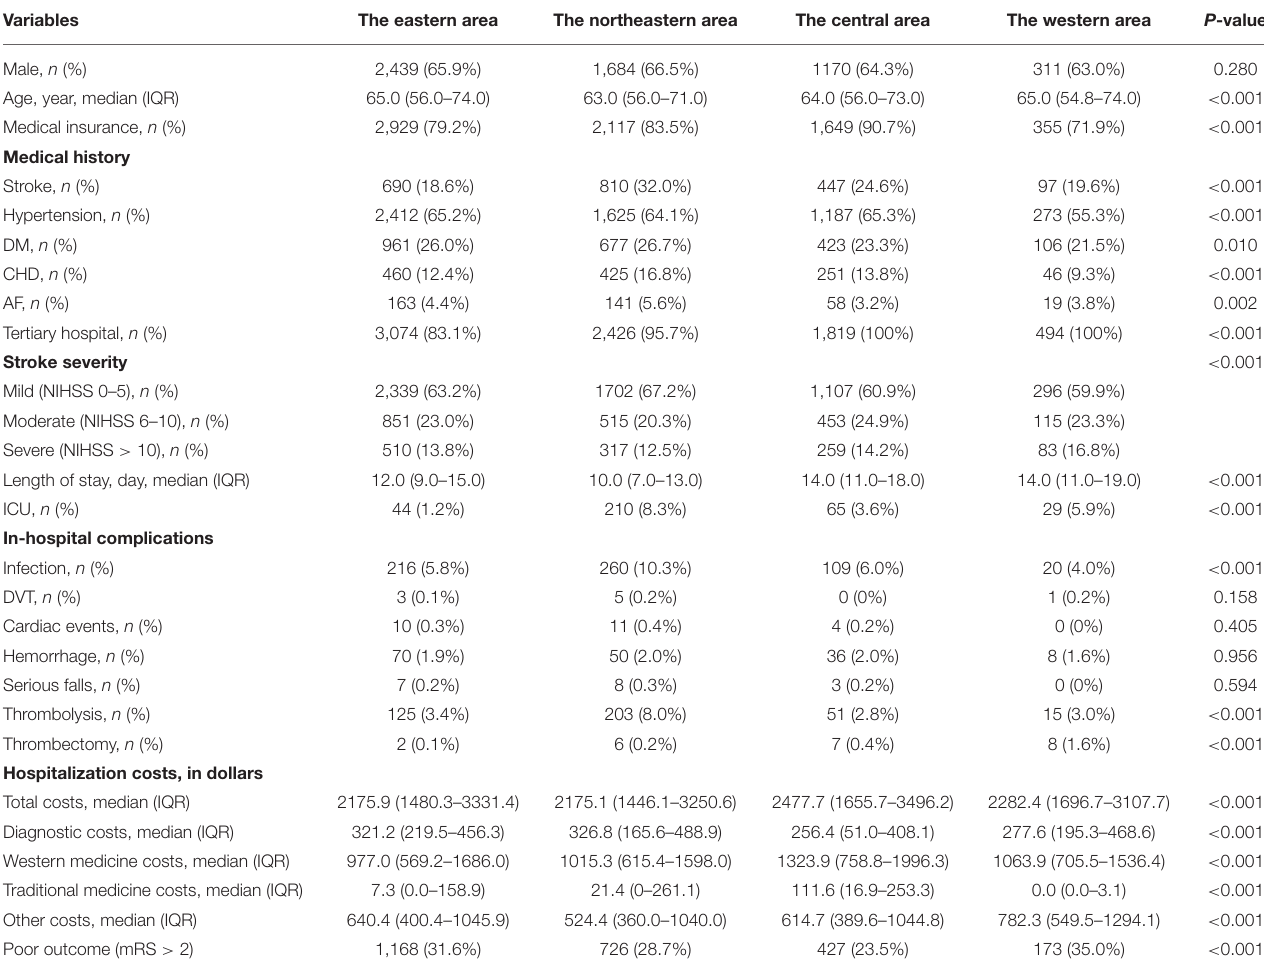
TABLE 1 | Basic characteristics of different